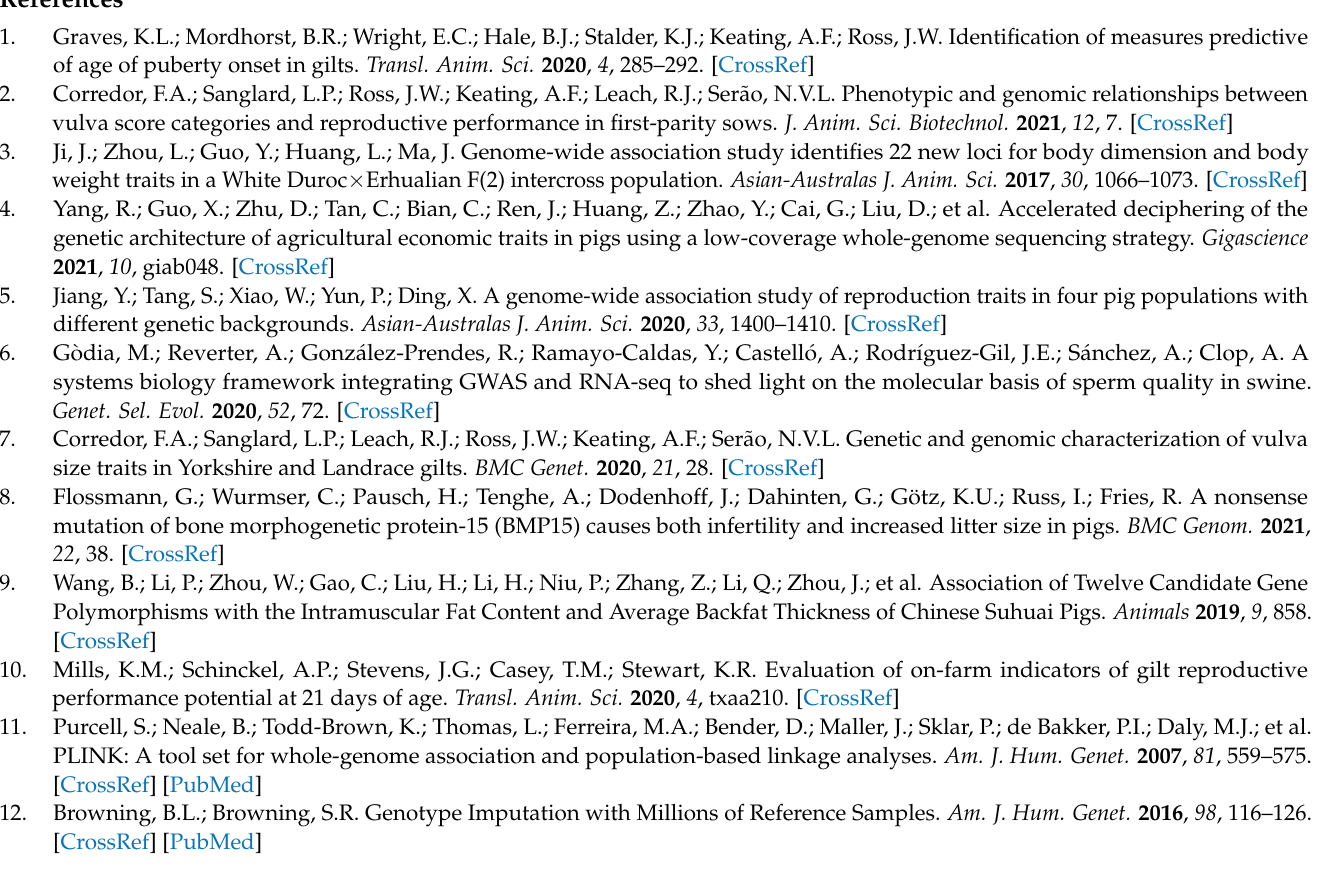
phenotypes of Suhuai pigs. Figure S4: Density map of SNPs. Figure S5: Allele concordance rate of each chromosome. Figure S6: PCA plot of 270 Suhuai pigs by Chip data. Figure S7: Q-Q